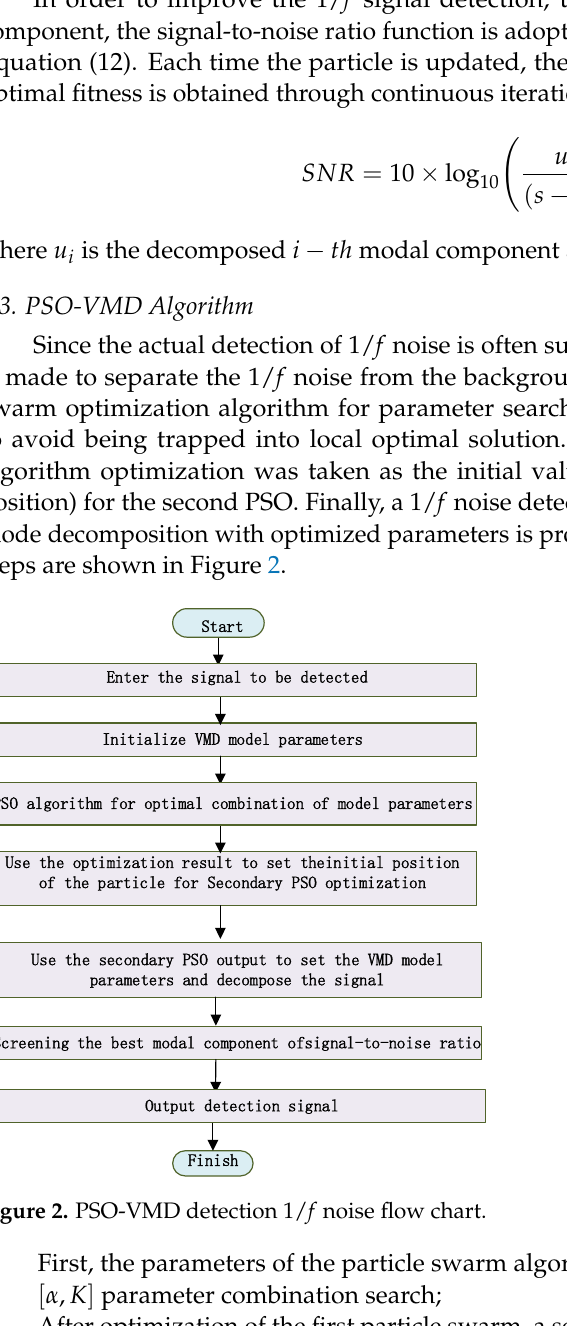
Figure 1. Schematic diagram of learning factor finding.